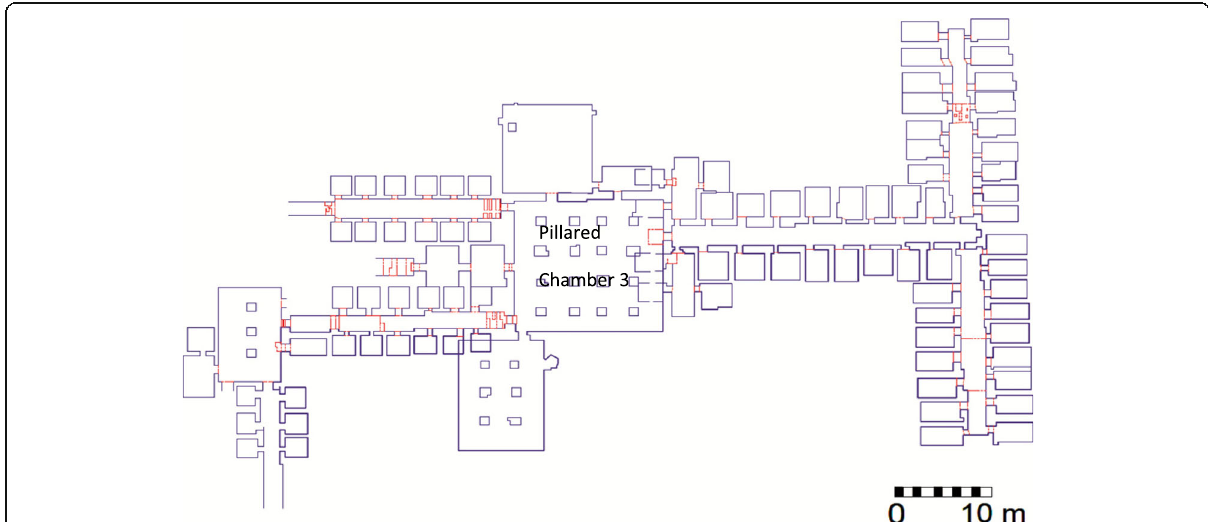
Fig. 3 The present layout and plan of the tomb of Sons of Ramsses II (KV5). The Measurements of the KV5 are: Maximum height: 2.85 m. Minimum width: 0.61 m. Maximum width: 15.43 m. Total length: 443.2 m. Total area: 1266.47 m 2 . Total volume: 2154.82 m 3 . Pillars Conditions are excavated, cutting finished, decorated, decoration damaged, damaged